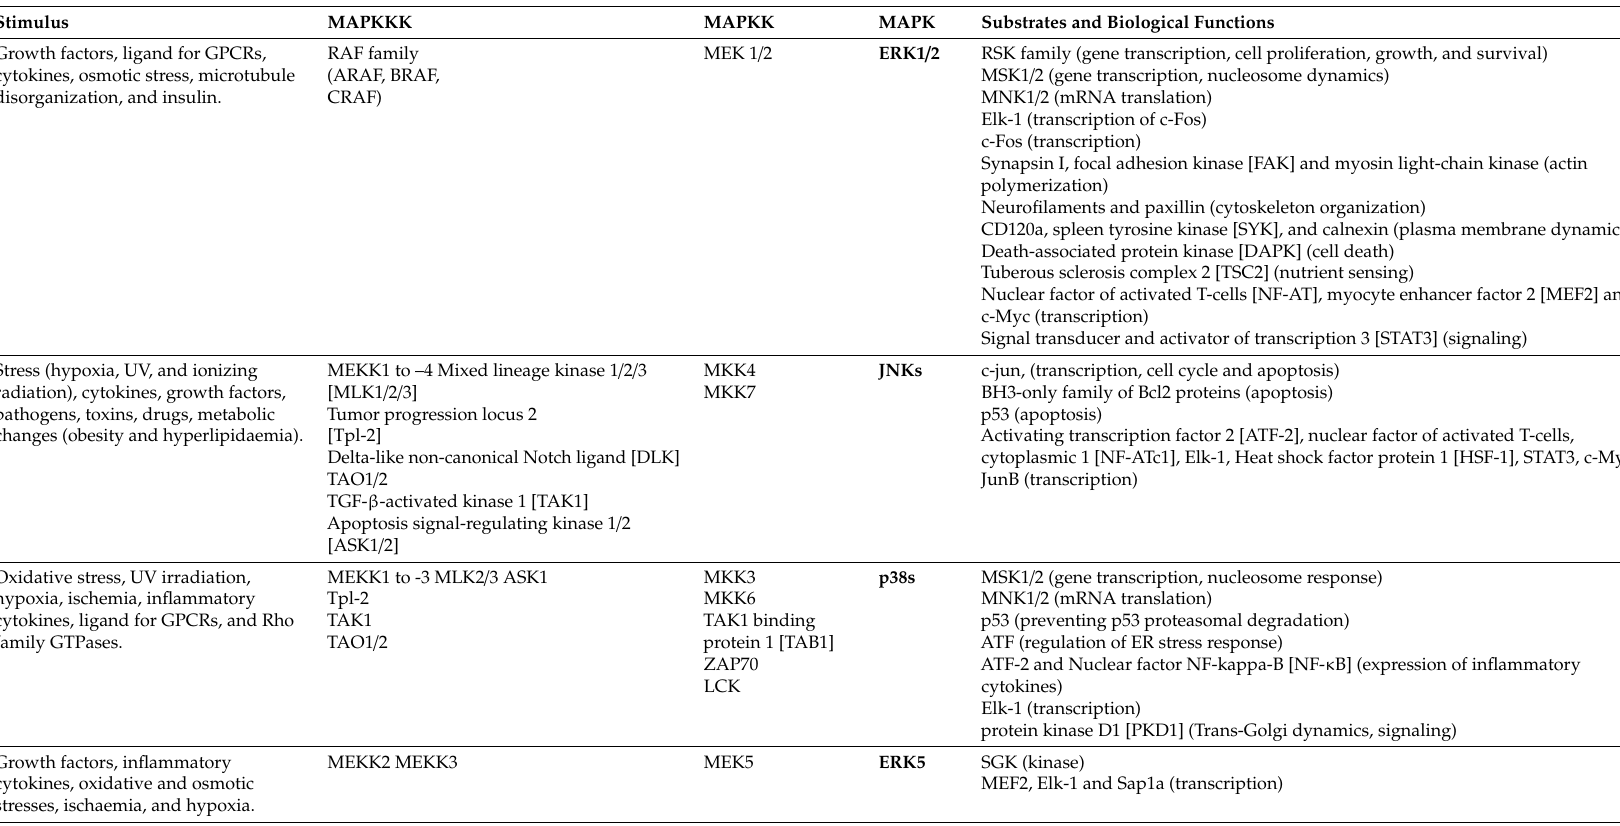
Table 1. Conventional MAPKs signaling cascades and their major